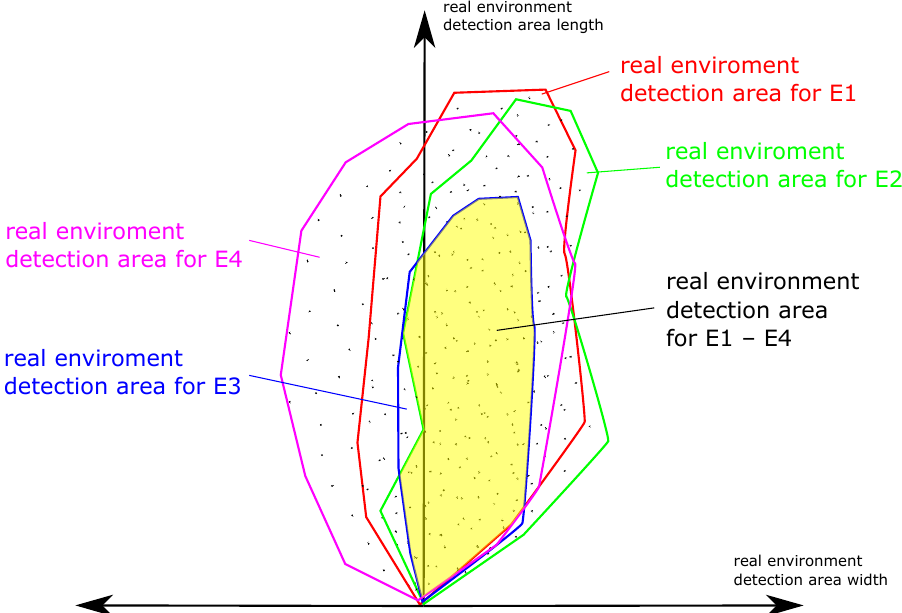
Figure 12. Evaluation of a real environment detection area matrix (REDAM): From the perspective from the top of the applicate axis, the REDA can be identified (yellow area) which results under all environmental